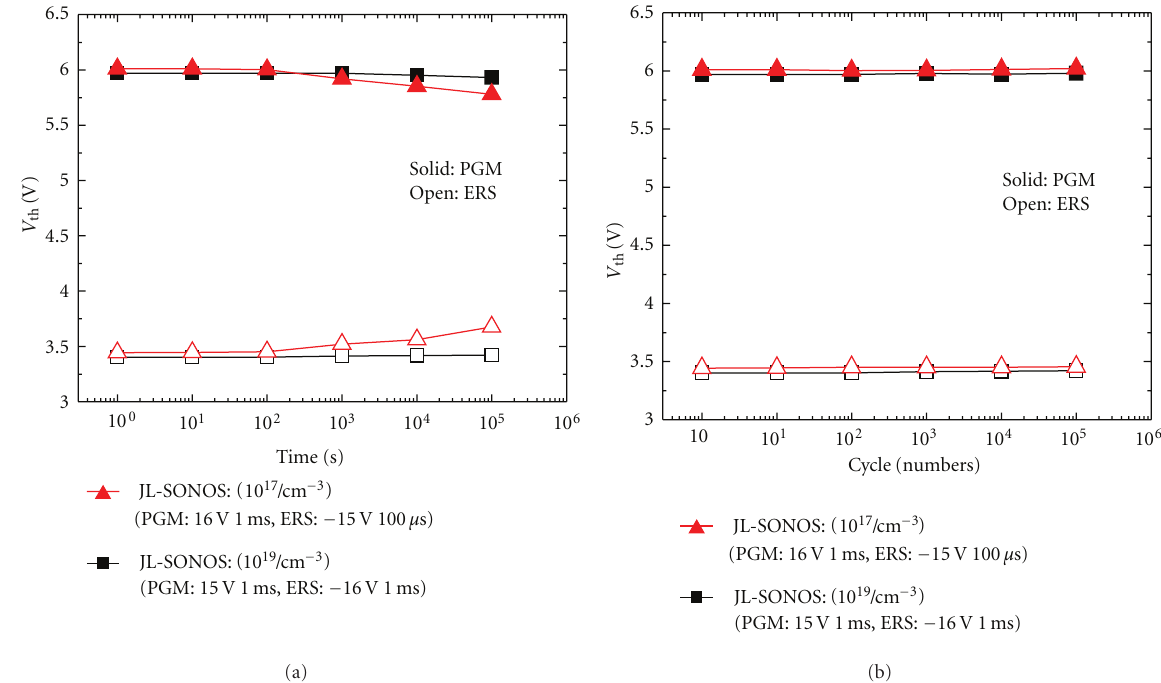
Figure 16: (a) Retention characteristic at 85 ◦ C for JL-SONOS memory device with channel doping of 1 × 10 17 cm − 3 .and 1 × 10 19 cm − 3 . (b) Endurance characteristic at 85 ◦ C for JL-SONOS memory device with channel doping of 1 × 10 17 cm − 3 .and 1 × 10 19 cm − 3 . (Reprinted with permission from [45]. [2011]